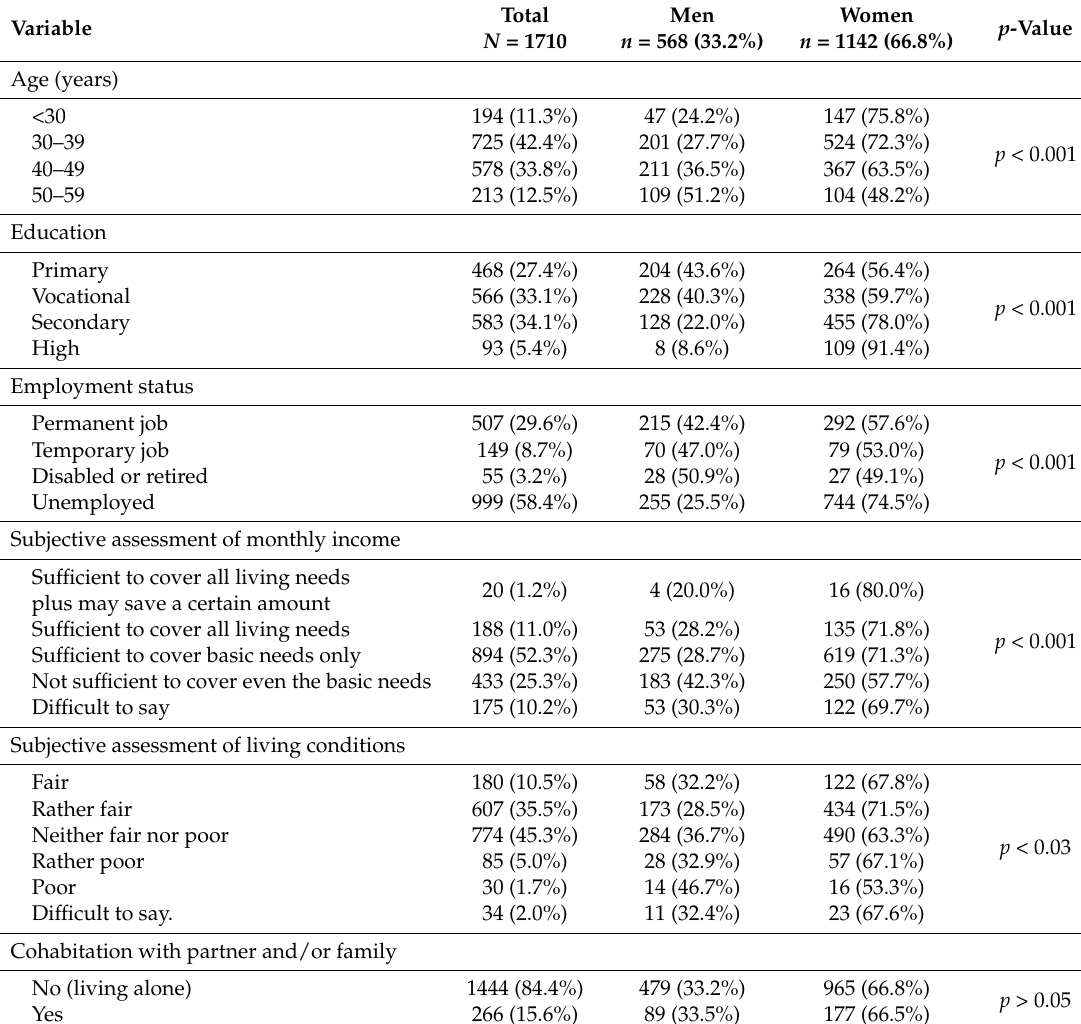
Table 3. Characteristics of the study population N =